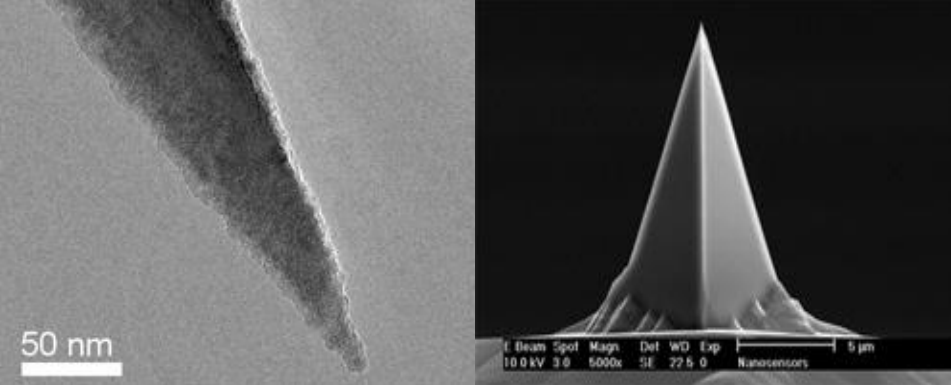
Figure 4. The shape of the AFM probe tip.